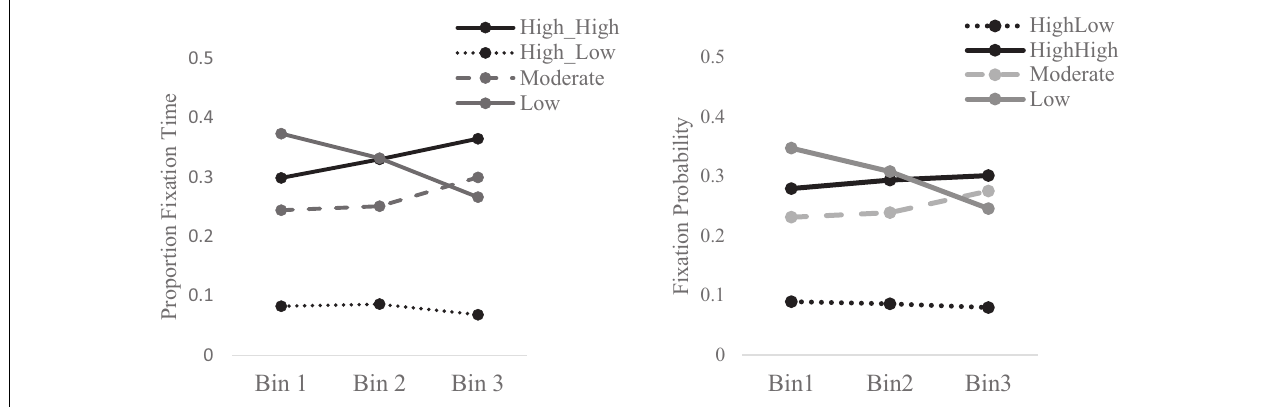
FIGURE 3 | Proportion fixation time (left) and fixation probability (right) for each of the four features (High_High, High_Low, Moderate, Low) across time (i.e., in each of the three Bins).